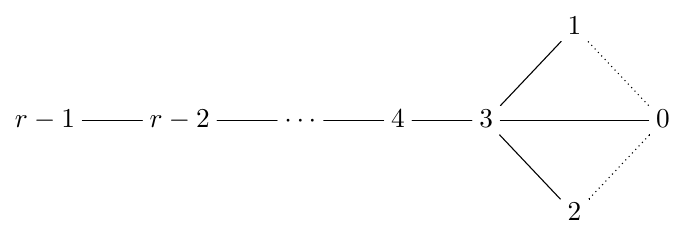
Figure 4. The bi-graph of the ideal triangulation of the punctured disk with r marks on the boundary having a self-folded triangle inside an internal